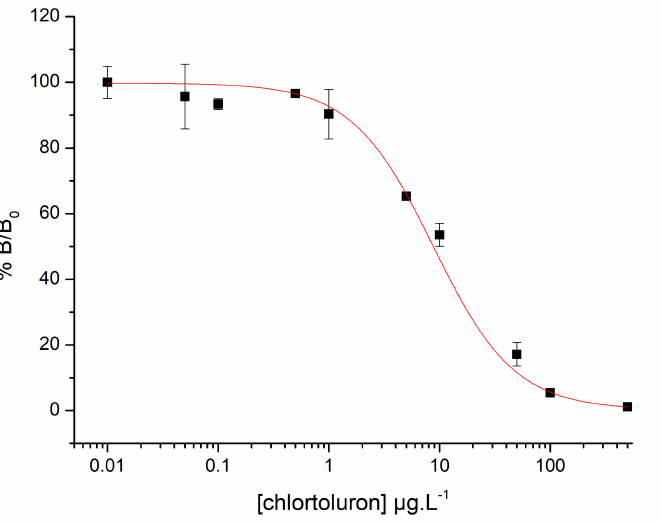
Figure 5. Calibration curve (R 2 = 0.999) showing %B/B 0 versus chlortoluron concentrations, obtained with chlortoluron concentrations of 0, 0.05, 0.1, 0.5, 1, 5, 10, 50, 100, and 500 µ g · L − 1 . A LOD of 2.7 µ g · L − 1 and EC50 of 8.8 µ g · L − 1 were calculated as the chlortoluron